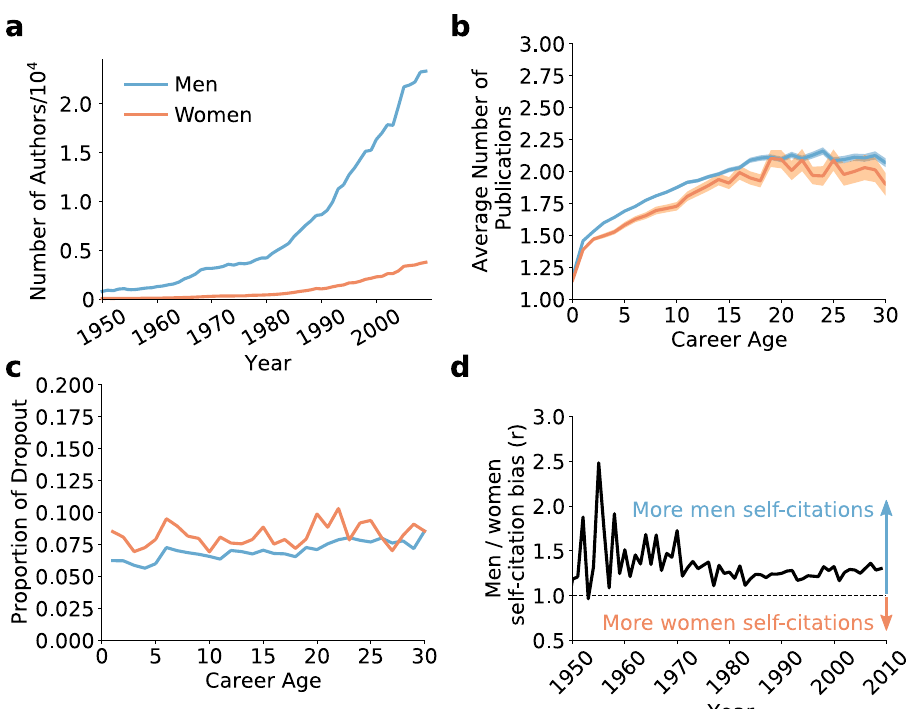
Fig. 1 Rate of growth of women participation, average publications by career age, dropout rate and annual ratio of men/women self-citations. a Number of men (blue) and women (orange) authors per year. b Average number of publications by authors' career age. The shaded area shows the standard deviation. c Proportion of men and women authors who drop out compared to the remaining active authors per career age. d Normalized ratio of men/women self-citations computed from (1) during the time period of interest. The horizontal dashed line is the line of equilibrium; data points above the equilibrium line indicate a higher ratio of men's self-citation, and points below the line imply a higher ratio of women's self-citation.